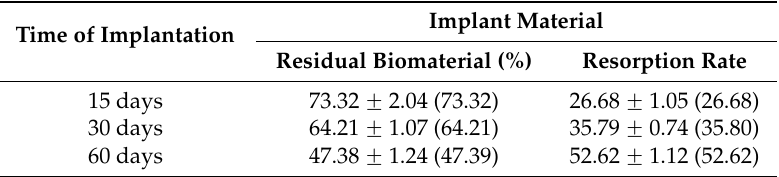
Table 4. Residual biomaterial and resorption rate 15, 30, and 60 days after implantation. Mean ± SD (Median).